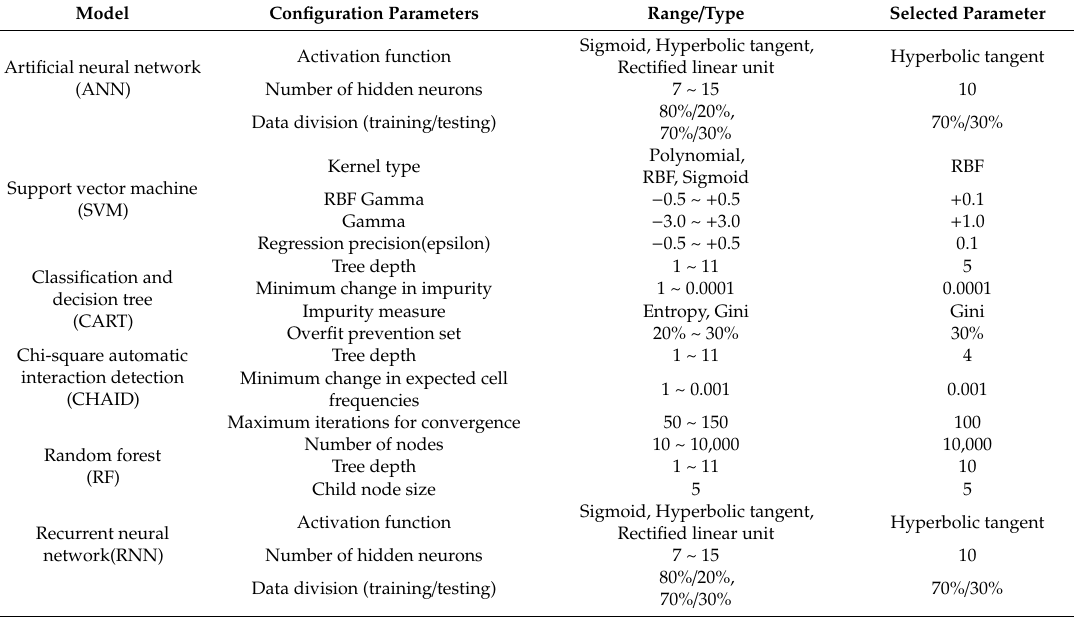
Table 2. The specified conditions for each of the six machine-learning